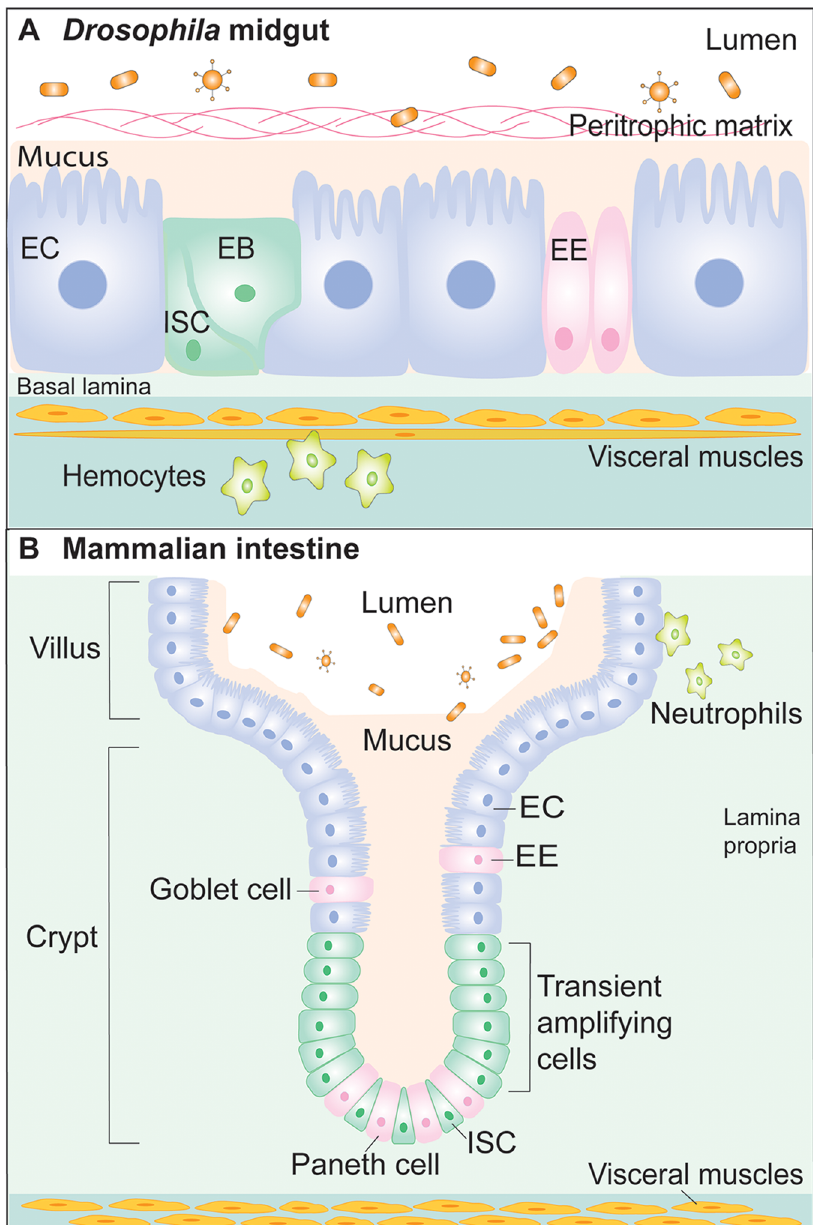
Fig 1. Parallels between the Drosophila and mammalian gut epithelia. ( A ) The fly midgut is composedof absorptive enterocytes (ECs) and secretory enteroendocrine cells (EEs) that arise from differentiationof the basallyembedded intestinal stem cells (ISCs). Enteroblasts(EBs) are transient progenitors destinedto differentiate into ECs. The epitheliumis protectedby the peritrophicmatrix and thin mucus layer apicallyand is sheathedin a basal lamina and visceral muscle cells. ( B ) Similarly, the mammalianintestinalepitheliumis composed of progenitorand Paneth cells residingat the base of crypts and absorptivecells (ECs) and secretory cells (EE and Goblet cells) that progresstowards the apex of the villus. The mucus layer protects the gut epithelialcells from direct contact with commensal microbes. Hemocytes ( A ) or Neutrophils ( B ) transmit secreted signalsto the gastrointestinal